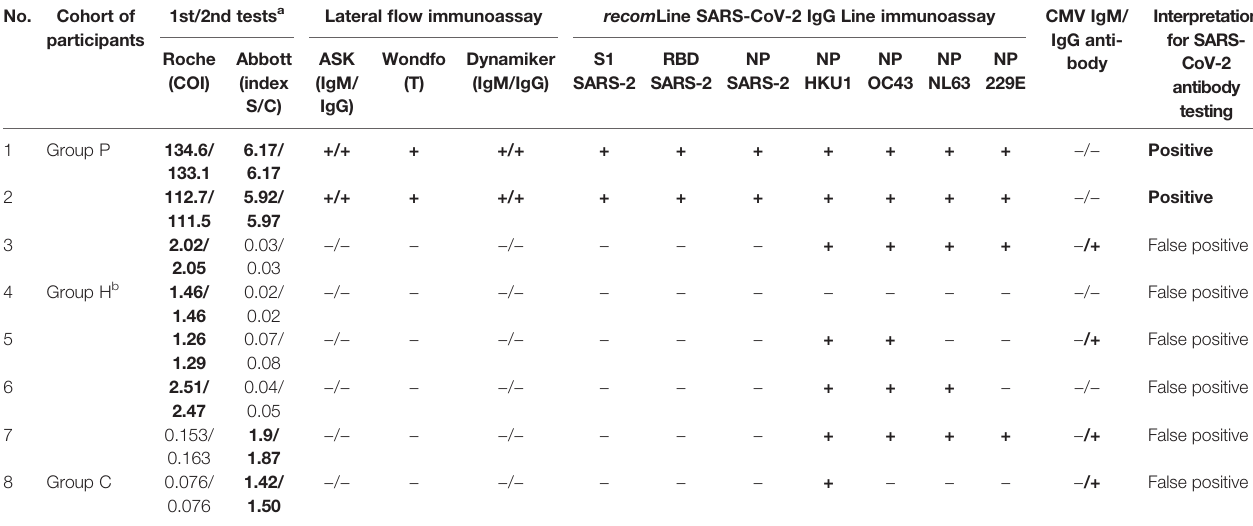
TABLE 2 | Summary of eight participants with positive results from either Roche Elecsys ® Anti − SARS − CoV − 2 test (Roche) or Abbott SARS-CoV-2 IgG assays (Abbott) in a seroprevalence survey (n = 2105) conducted from June 25 to July 29, 2020. No. Cohort of 1st/2nd tests participants